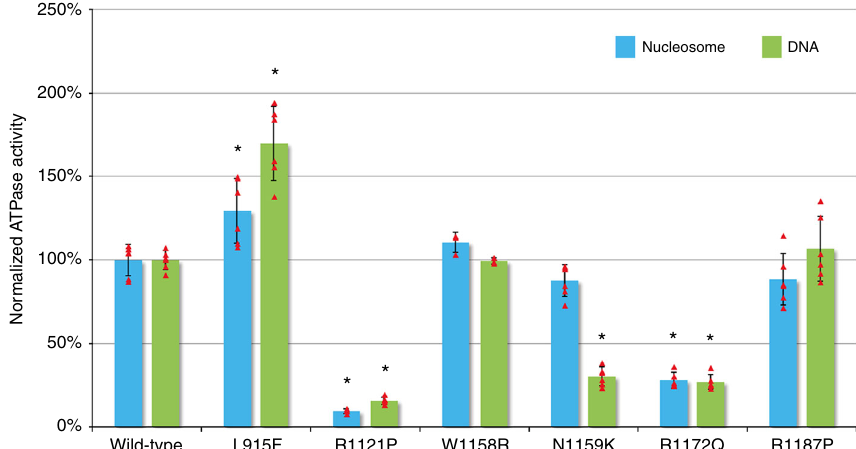
Fig. 3 ATPase assays. Radiometric ATPase assays were performed to assess the activity of the mutant proteins relative to wild-type, in the presence of recombinant nucleosomes (blue), dsDNA (green), or in the absence of DNA substrates as a control (Supplementary Fig. 4). Released phosphate was separated from unhydrolyzed ATP by thin layer chromatography, and detected by exposure to a phosphorimager. The experimental values (percentage hydrolyzed ATP) for the different mutant conditions were normalized to values for the wild-type condition within the experiment, to derive a normalized ATPase activity. The experimental data are presented as means ± standard deviation, individual data points are shown as red triangles. Three independent experiments from two individual puri fi cations (wild-type, p.Leu915Phe, p.Arg1121Pro, p.Asn1159Lys, p.Arg1172Gln, and p.Arg1187Pro) ( N = 6) or one puri fi cation (p.Trp1158Arg) ( N = 3) were performed. Raw values from the individual experiments can be found in Supplementary Data 2. Asterisk (*) indicates signi fi cant difference for mutant values compared to wild-type values (unpaired t -test, P < 0.05) within the same substrate